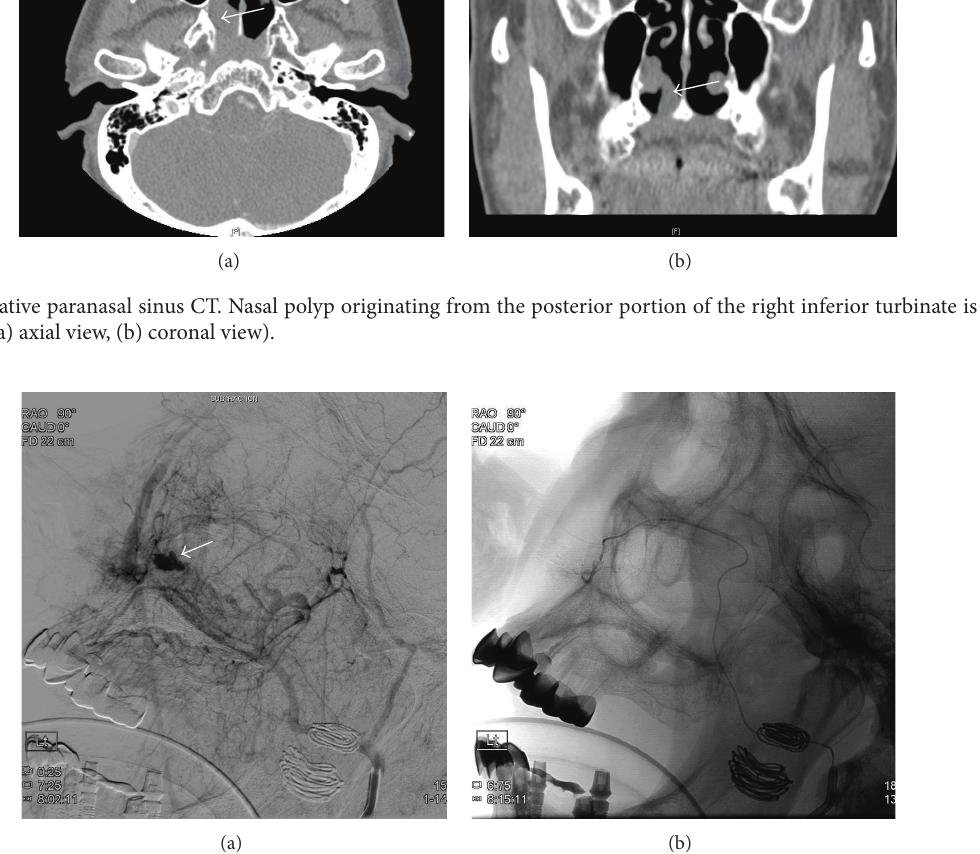
Figure 2: Angiography and arterial embolization. A pseudosac was found at the distal part of the right maxillary arterial branch, but a definite bleeding focus could not be found ((a) preembolization, (b)